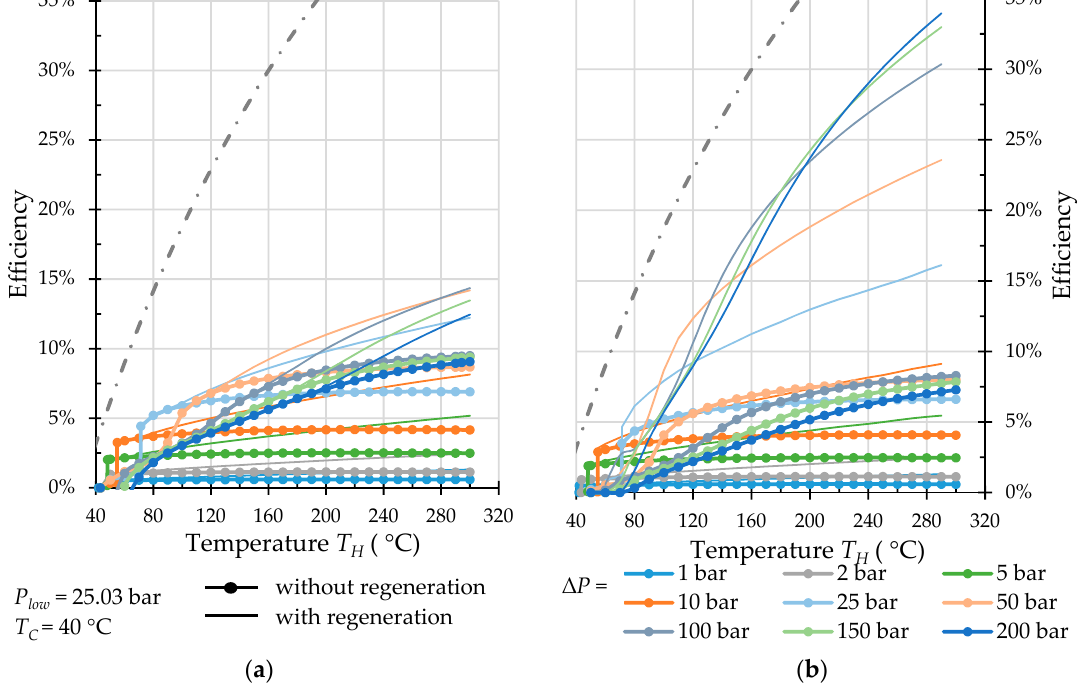
Figure 11. Efficiency of regenerative Worthington-type machine ( a ) and Bush-type machine ( b ) operated with refrigerant R32.